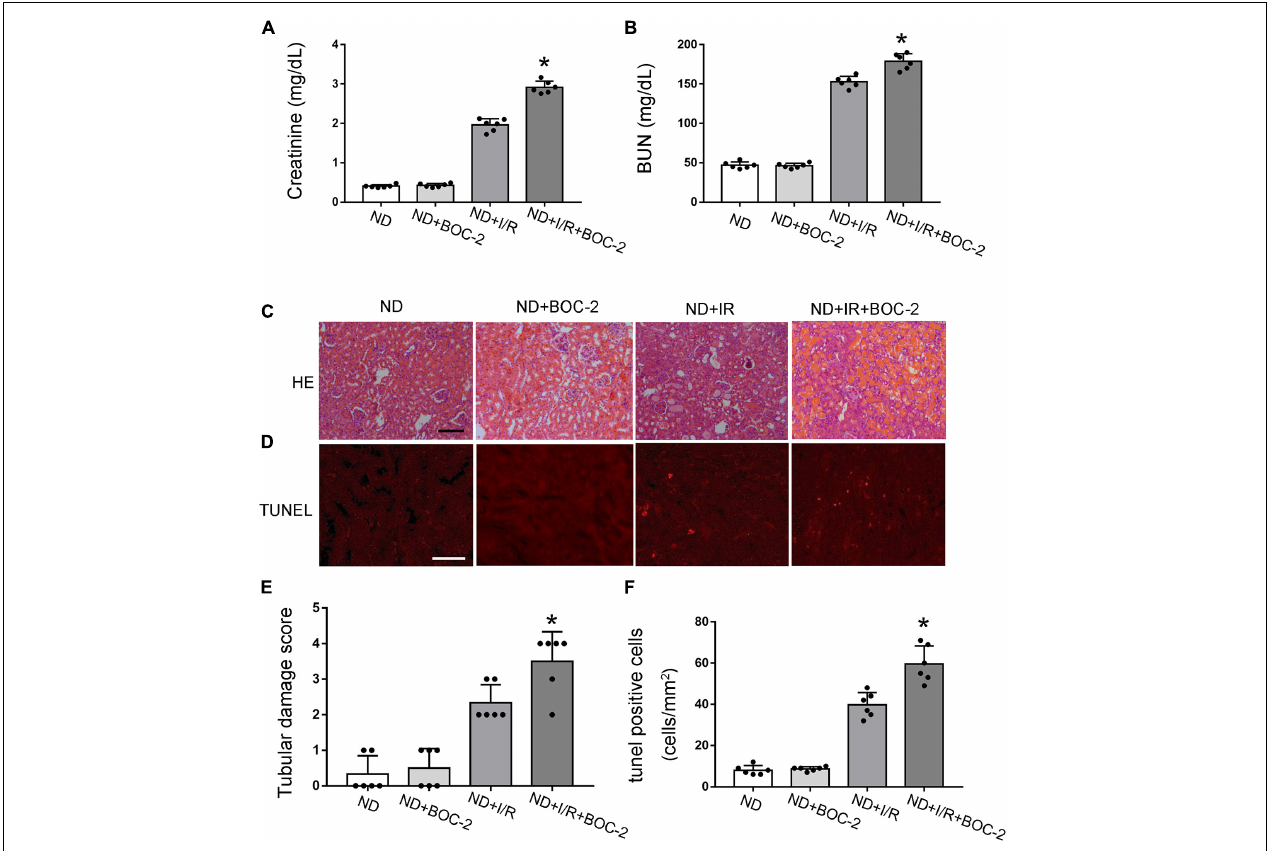
FIGURE 4 | Di- tert -butyl dicarbonate (BOC-2) treatment could deteriorate renal function and pathological injury after ischemic injury in non-diabetic (ND) mice. Male C57BL/6J mice were subjected to sham operation or 30 min of bilateral renal ischemia followed by 48 h of reperfusion (I/R48). For the BOC-2 group, BOC-2 was given at a dose of 5 µ g/kg intraperitoneally 30 min before renal ischemia–reperfusion. (A,B) Serum creatinine and blood urea nitrogen (BUN). (C) Hematoxylin and eosin (HE) staining for renal tissues. Scale bar, 100 µ m. (D) TUNEL assay to reveal apoptosis of renal tissues. Scale bar, 50 µ m. (E) Semi-quantification for renal tissue damage. (F) Statistical analysis for TUNEL-positive cells. All the data are shown as the mean ± SD ( n = 6). * p < 0.05 vs. the relevant ND + I/R